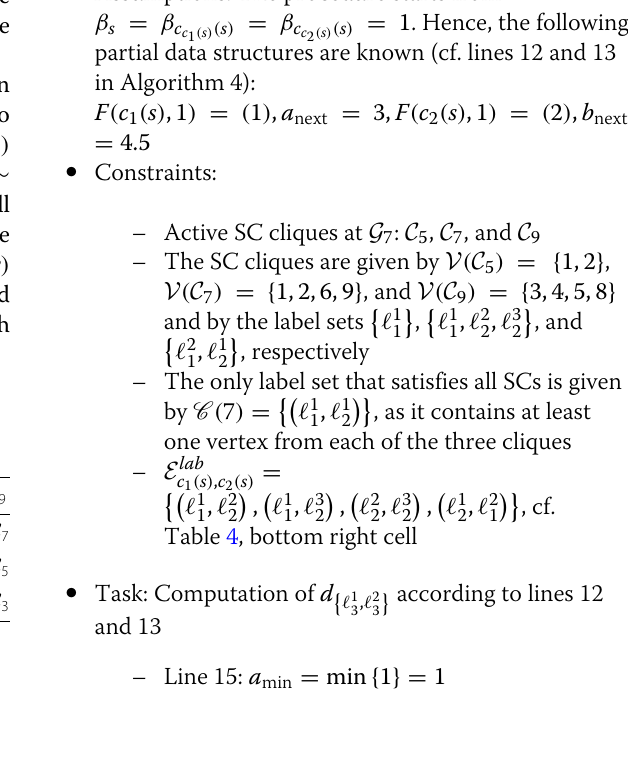
Dynamic programming: weight computation via